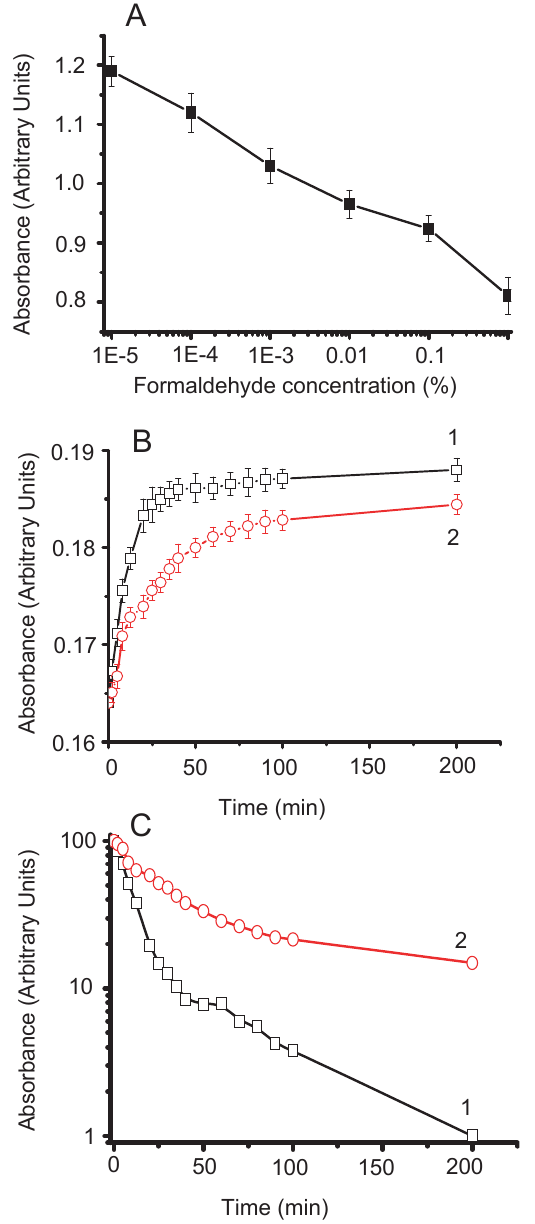
Figure 6. Reaction of formaldehyde with thiol groups of neuronal tau. Neuronal tau (2 m M) was re-suspended in phosphate buffer containing DTNB (20 times in excess to the protein in molar ratio) in the presence of formaldehyde at different concentrations at 37 u C for 120 min. The DTNB absorbance ( A , 412 nm) was measured. Under the same conditions, native tau (Curve 1) and 0.005% formaldehyde-treated tau (Curve 2) were re-suspended in 2 m M DTNB ( B ), and aliquots were taken to measure the absorbance at different time intervals. The same data shown in B are also plotted in semilogarithm ( C ) according to Tsou’s method [29].